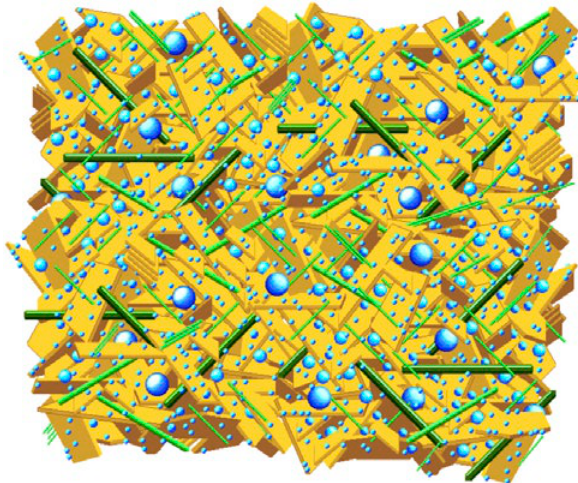
Figure 12. Sediment as initially flocculated has its silica particles ‘coating’ other sediment particles and interspersed as random lin- king chains (From Elliston 9 , 2017, p.101).